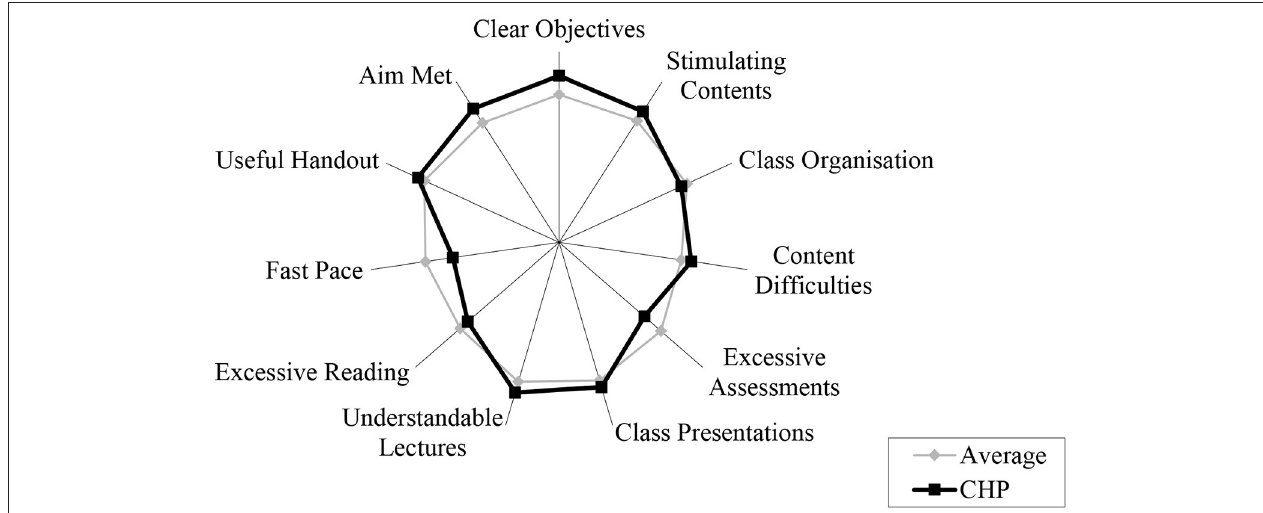
FIGURE 2 | Student feedback on health courses at La Trobe University (2002). Note: a higher score (longer distance from the center) indicates more positive